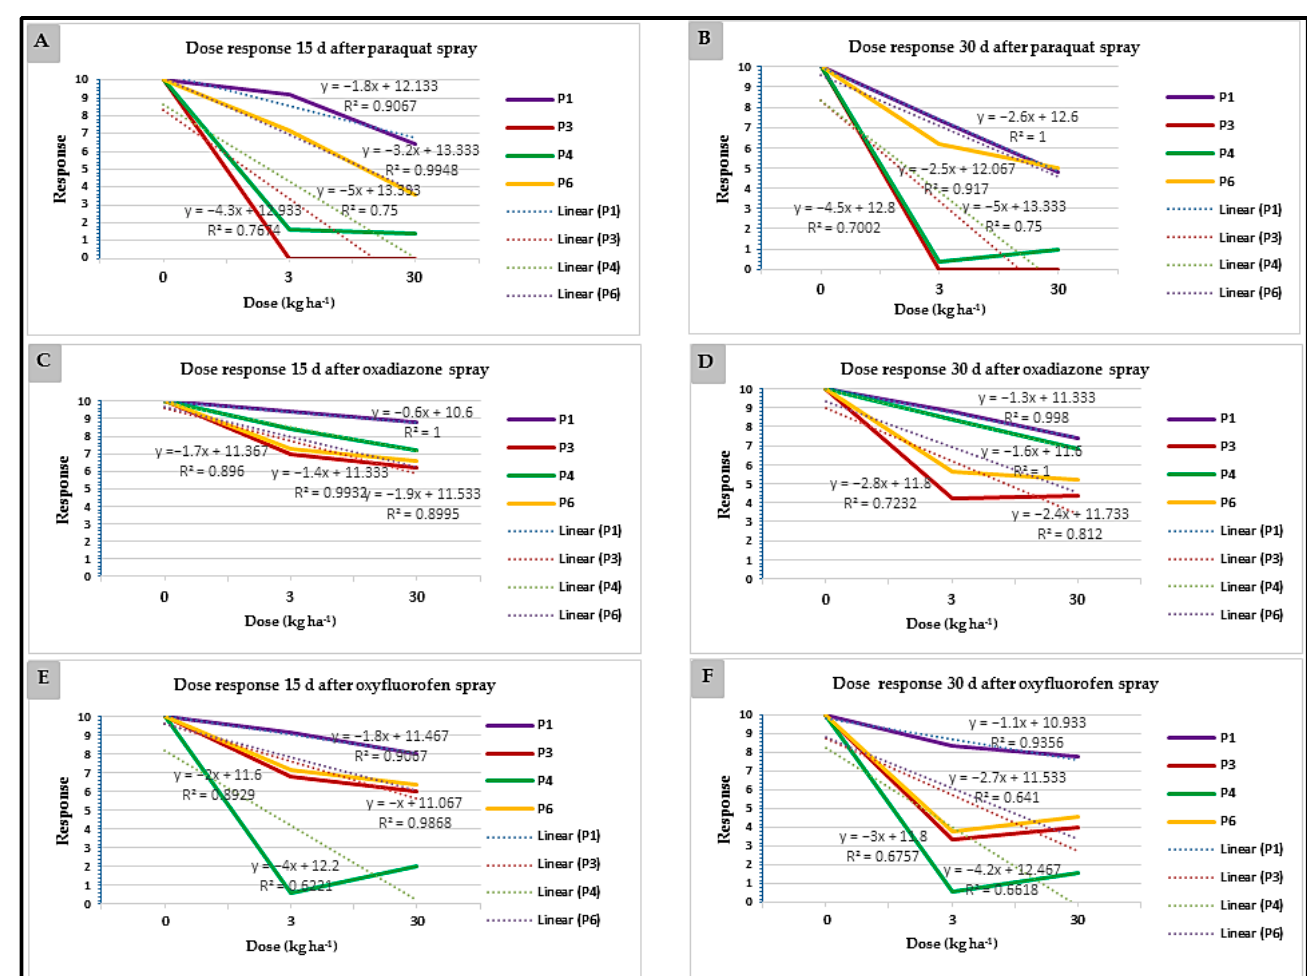
Figure 6. Dose–response curve of three herbicides applied on four populations of C. bonariensis (P1, P3, P4, and P6) sown in a pot experiment and sprayed at two dates at full vegetative growth stage (paraquat, ( A , B ); oxadiazon, ( C , D ); oxyfluorofen ( E , F )). Oxyfluorfen reduced weed growth by 20%, while the effect of oxadiazon was not more than 12%. The effect of the three herbicides on other weed populations varied. Paraquat was the most effective and almost eliminated weed population from the al-Twal site and, to a lesser extent, that of the University Research Station. This herbicide reduced the growth of the University Campus population of C. bonariensis by 64% compared with the control. The effect of oxyfluorfen on the al-Twal weed population was severe, resulting in an 80% growth reduction. In contrast, its effect on other populations was lower and similar to that of oxadiazon, showing little difference in its effect on the growth of weed populations from all sites. Still, paraquat remained more effective compared with the other two herbicides. It showed little difference in their effects on all populations except the al-Twal population, which was more affected by oxyfluorfen (Table 5 and Figure 6). Results of herbicide applications at recommended and high rates and at two dates showed that the population grown from seeds collected from the date palm orchard (Tal-al-Ramel site) was least affected or irresponsive to the three herbicides followed by the University Campus. In contrast, the al-Twal site population was most susceptible to paraquat and oxyfluorfen and much reduced in growth at both application rates but showed a lower response to oxadiazon herbicide (Table 5 and Figure